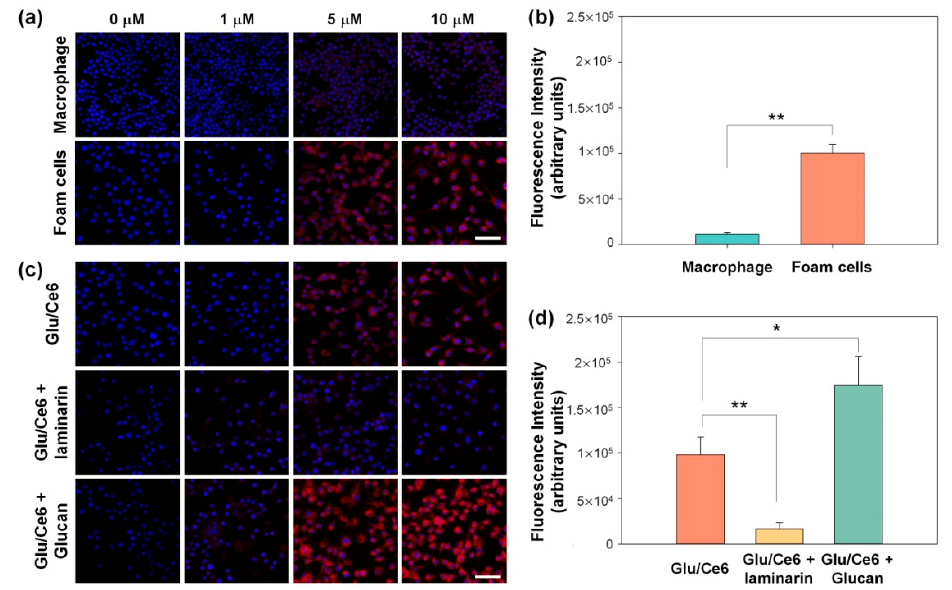
Figure 5. In vitro cellular internalization of Glu/Ce6 into macrophages and foam cells. ( a ) Confocal microscopy images of Glu/Ce6 internalization into macrophages and foam cells. Scale bar: 50 µ m. ( b ) Comparison of cellular internalization of Glu/Ce6 (equivalent 5 µ M Ce6) into normal macrophages and foam cells. ( c ) Cellular uptake of Glu/Ce6 against foam cells with or without pretreatment with laminarin or β -glucan. Scale bar: 50 µ m. ( d ) Comparison of Glu/Ce6 (equivalent 5 µ M Ce6) cellular uptake against foam cells with or without laminarin or β -glucan. ** p < 0.01, * p <